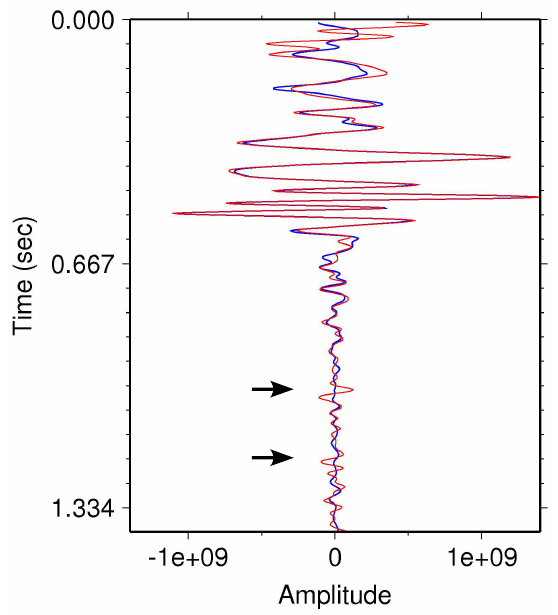
Fig. 3. Synthetic seismograms computed for the sound-speed and density profiles shown in Fig. 2. The blue line assumes that there is no suspended sediment whereas the red line includes the effects of the of suspended sediment. The intrusion at 750m and the sed- iment load below 900m produce additional reflectivity, arrowed. The seismic source function used in both cases was a zero-phase Ricker wavelet with a peak response at 20Hz that has a similar ver- tical resolution to that used for the seismic survey shown in Fig.